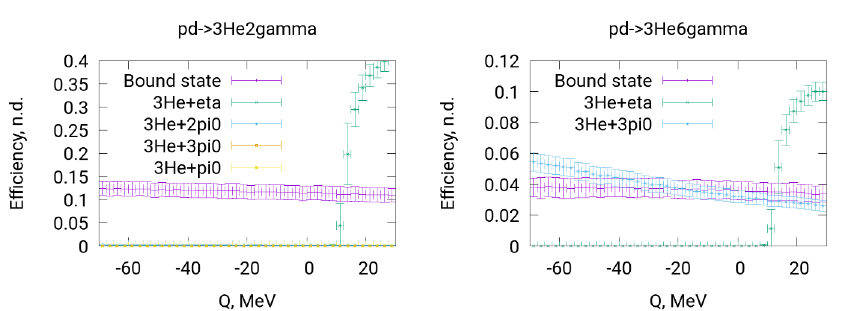
Figure 1. E ffi ciency distribution for di ff erent reactions obtained in pd → 3 He 2 γ and pd → 3 He 6 γ reactions analysis. Systematic uncertainties are taken into